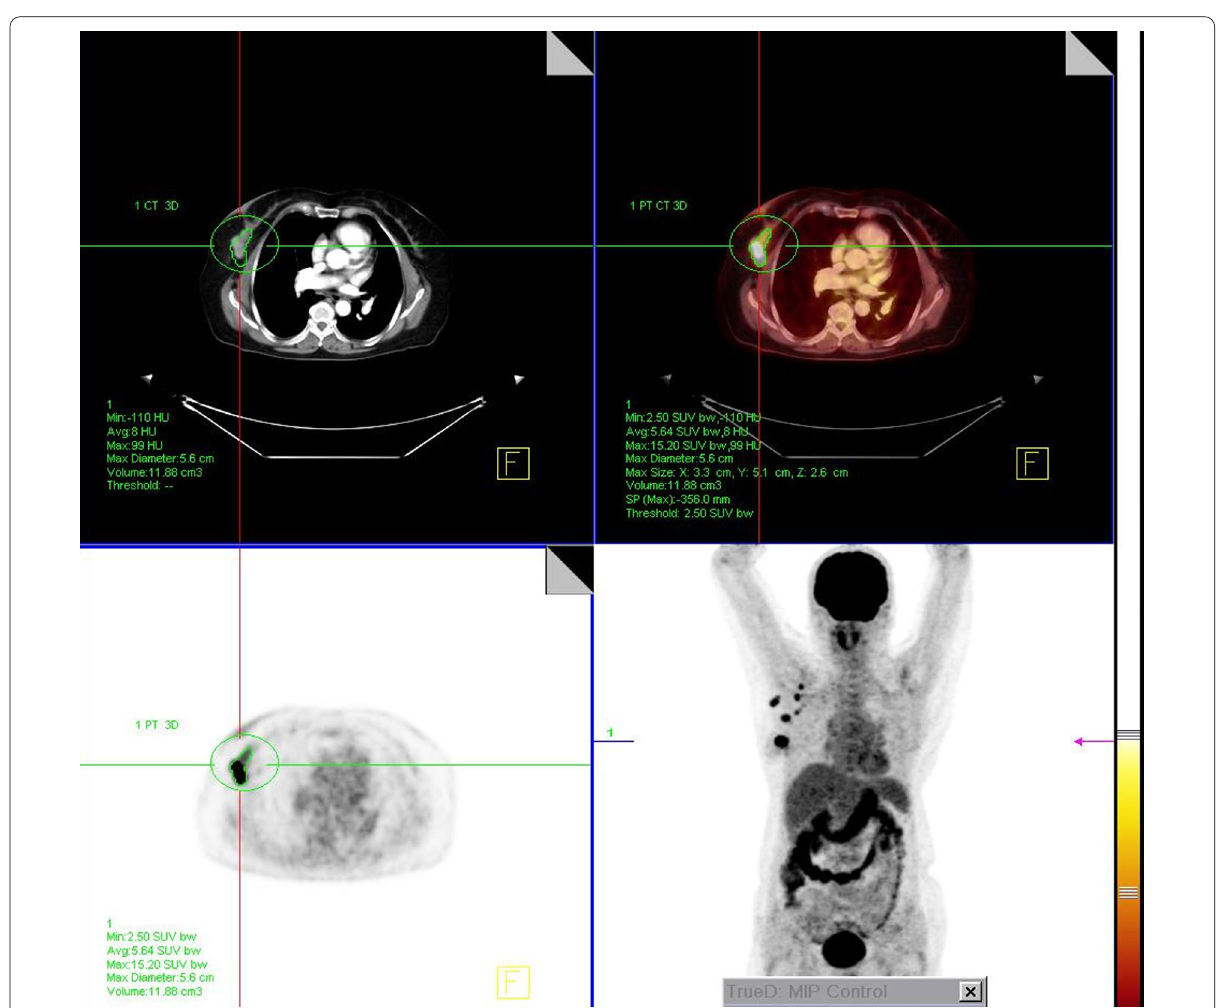
Fig. 6 Axial CT, PET and MIP Fused PET-CT. Patient with recurrent locoregional tumor (SUVmax: 15.20) and ipsilateral lymph node metastasis (stage